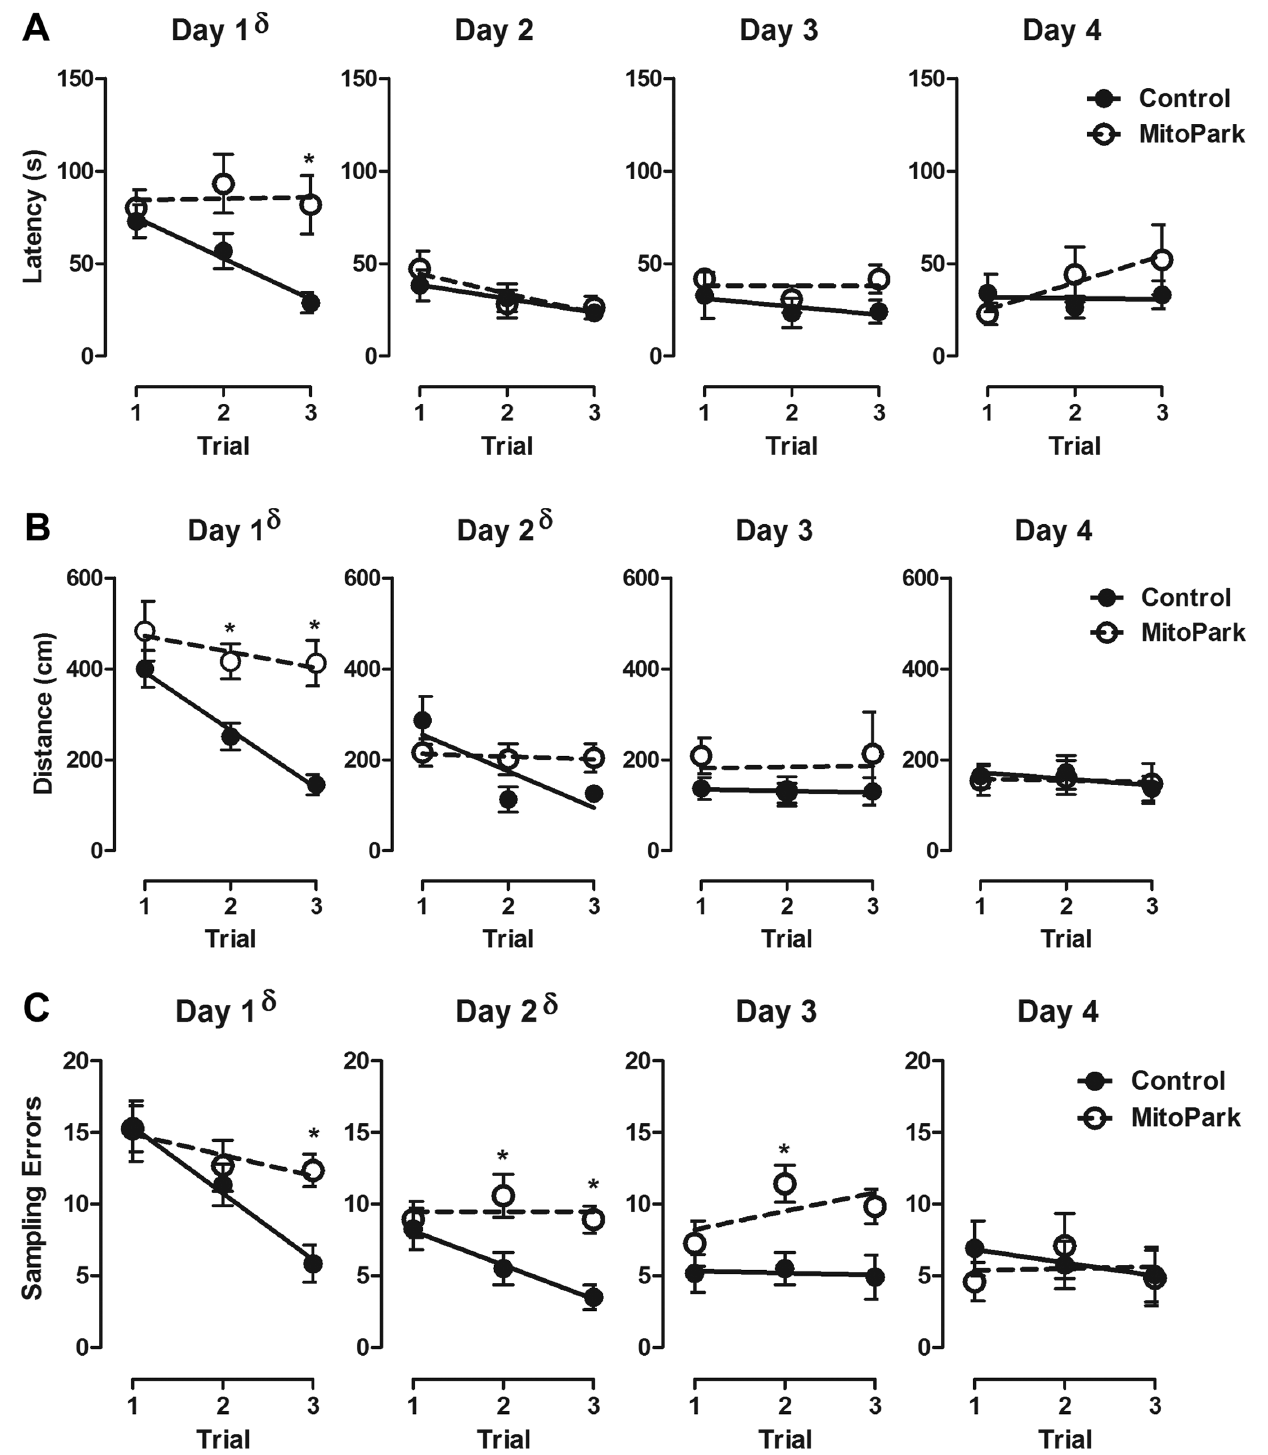
Figure 3. MitoPark mice exhibit impaired within-day spatial learning. Spatial learning in 8 week old MitoPark or wild-type phenotype littermate control mice within a given day was assessed by comparing performance across successive daily trials. (A) Latency to locate the target hole and (B) Distance traveled to locate the target hole measured for each of the three trials on four successive days. (C) The number of sampling errors recorded for each trial measured over the four successive training days. Data represent mean 6 SEM, (n=8 mice/group). Significant post hoc effect indicated (*p , 0.05) for MitoPark and same day and trial littermate control. 1 p , 0.05 difference in learning curve (slope) between MitoPark and littermate control mice on a given day.